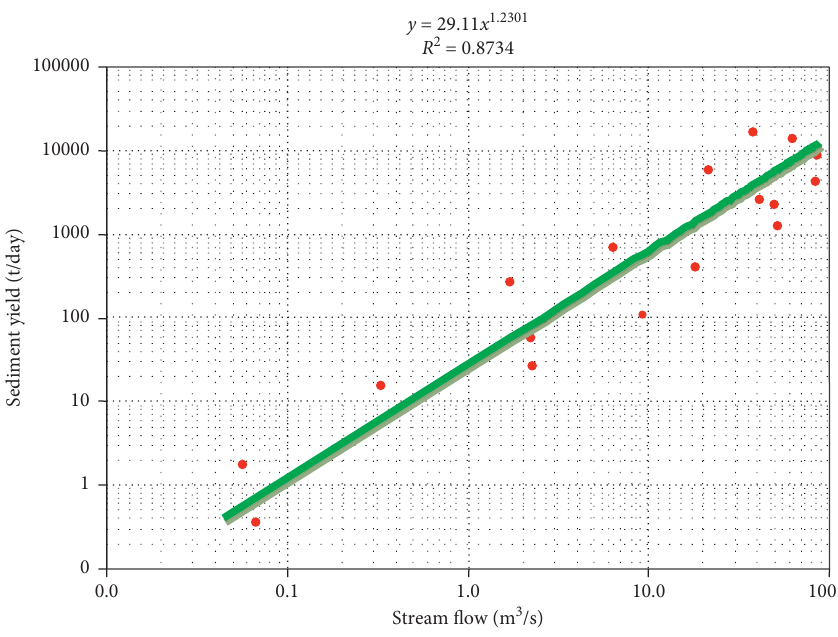
Figure 11: Sediment rating curve of Megech River near Azezo gauge